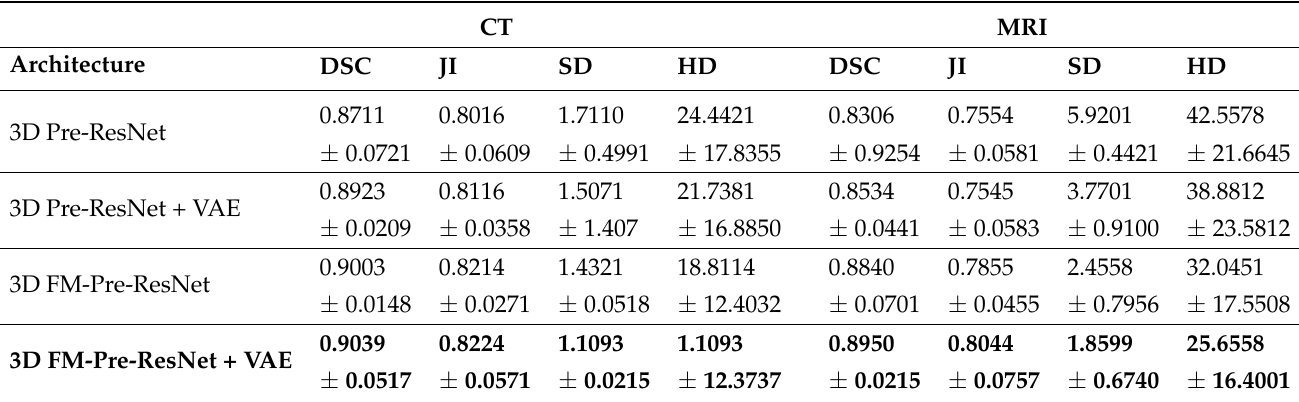
Table 2. Comparison of an average WHS results in terms of DSC, JI, SD, and HD on different architectures for the CT and MRI testing